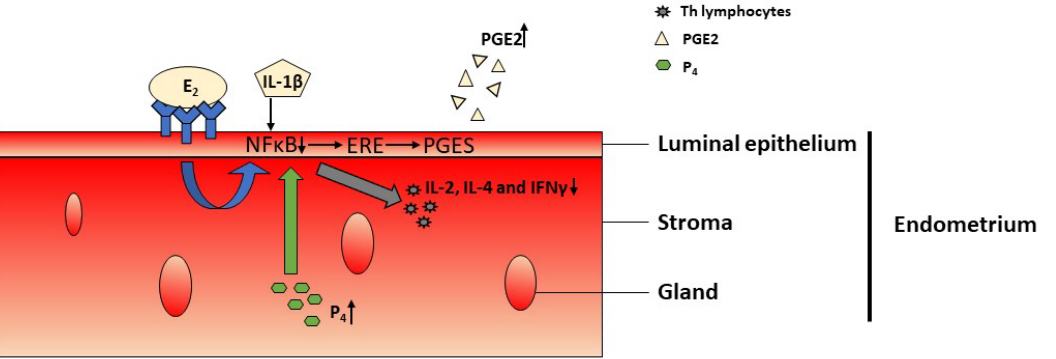
Figure 2. Changes during pregnancy development. Elevated levels of estradiol (E2) together with interleukin 1 β (IL-1 β ) and progesterone (P4) reduce nuclear factor kappa-light-chain-enhancer of activated B cells (NF κ B) activation, leading to an increase in the activity of estrogen response elements (ERE) in the DNA of endometrial luminal epithelium. This triggers an increase in the expression of prostaglandin E synthase (PGES) and production of prostaglandin E (PGE2). Reduced NF κ B activation causes the inhibition of interleukin 2 (IL-2), interleukin 4 (IL-4) and interferon gamma (IFNγ) production in T lymphocytes. ↑ : increase; ↓ : decrease.